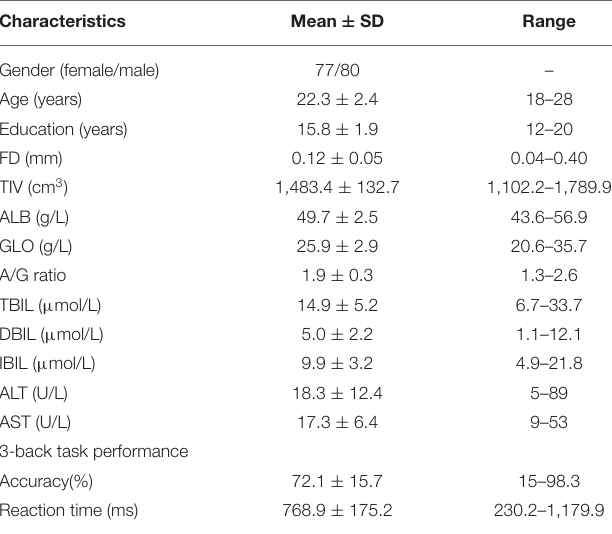
TABLE 1 | Demographic, cognitive, and serum liver function characteristics of 157 healthy participants.